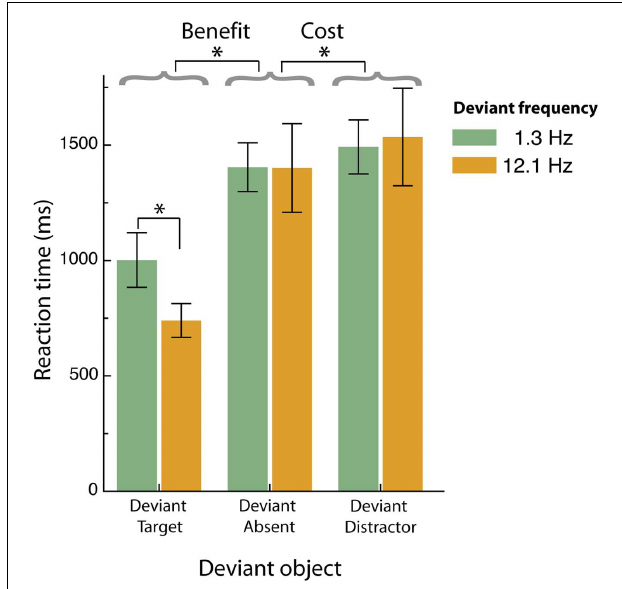
FIGURE 4 | Mean reaction times for correctly identifying the orientation of the target element (horizontal vs. vertical) when presented under the various temporal contexts in Experiment 2 (set size = 7 items). Error bars represent SE of inter-subject means ( n =